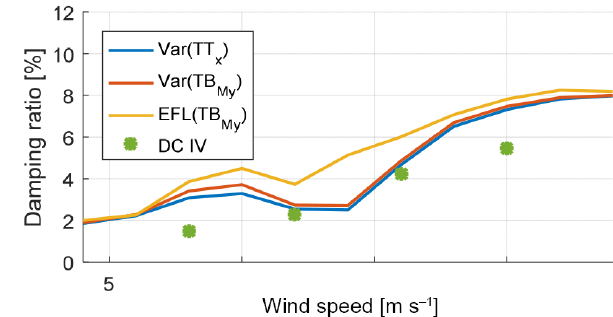
Figure 10. Damping ratio over wind speed for DC III and DC